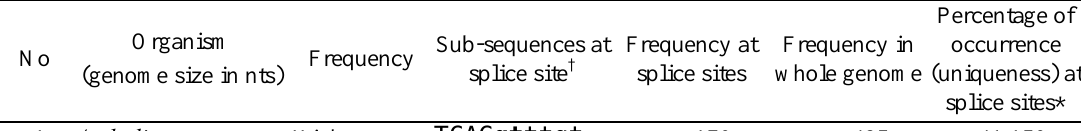
Table 4a. Frequency of occurrence of different sub-sequences (size ten) at the donor splice site region and the whole genome of the respective organisms